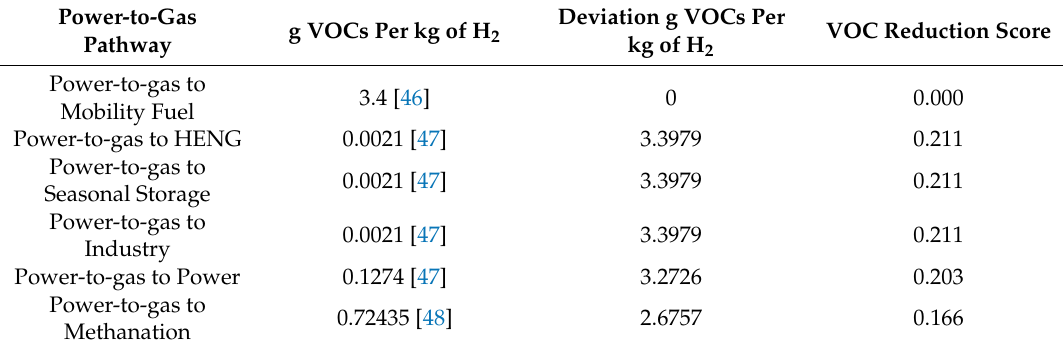
Table 8. VOC Emissions for power-to-gas Pathways—VOC Reduction Score.